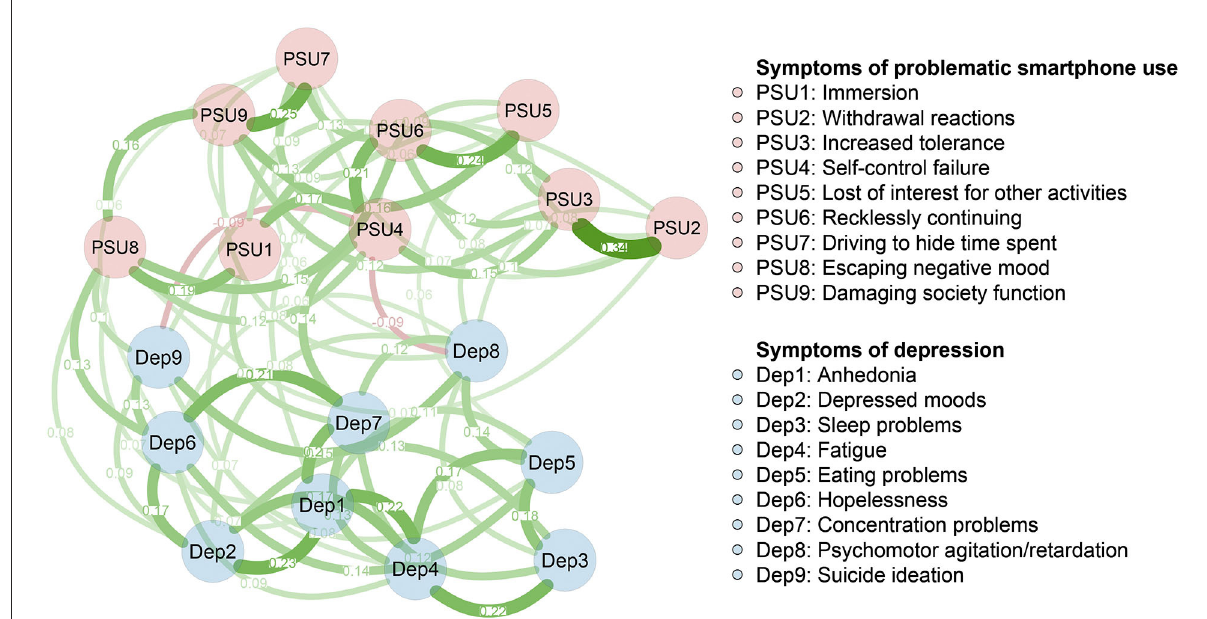
FIGURE1 Network structure of different symptoms of problematic smartphone use and depression. Green edges represent positive correlations and red edges represent negative correlations. The thickness of the edge reflects the magnitude of the correlation. The value on the edge represented the unregularized partial correlation coefficient of two corresponding